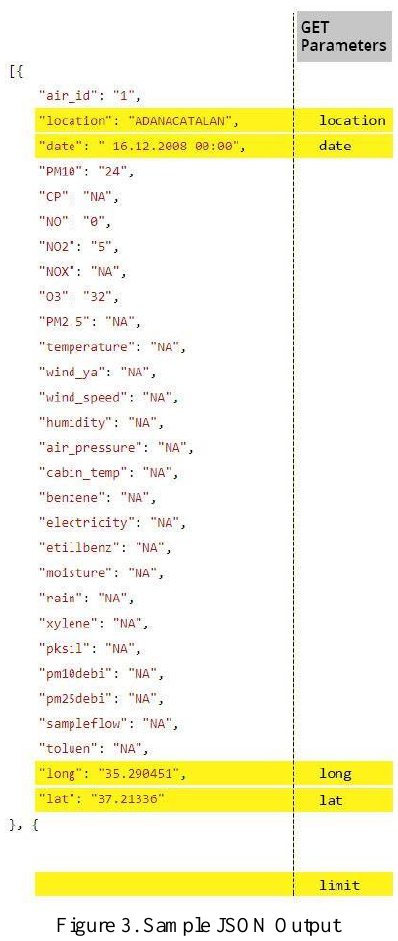
Figure 3. Sample JSON Output